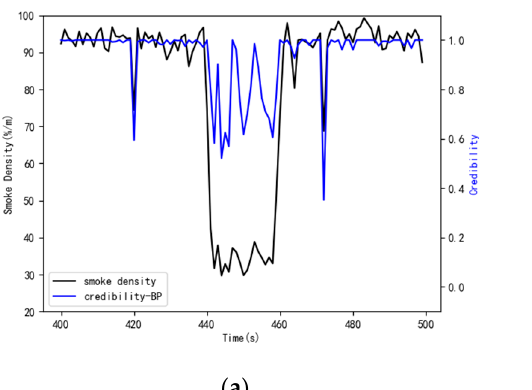
Figure 17. Comparison of credibility measurement models. ( a ) Simulation dataset. ( b ) Benchmark dataset.